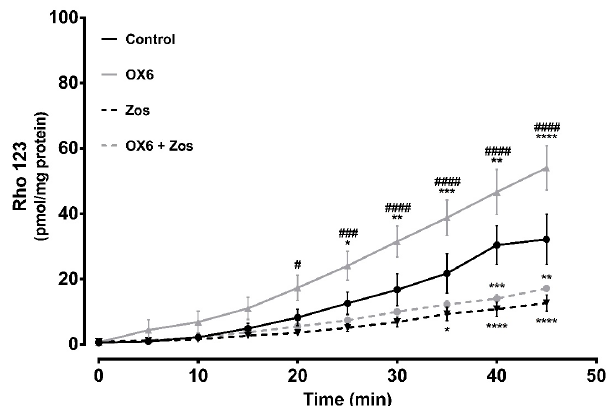
Figure 8. Short-term and direct effect of xanthone OX6 on P-glycoprotein (P-gp) activity, evaluated ex vivo. P-gp-mediated Rhodamine 123 (Rho 123) efflux was measured using 10 cm everted sacs from distal ileum. The sacs were filled with 300.0 μ M Rho 123 (serosal side). The dye secreted into the outside compartment (mucosal side) was assessed every 5 min for 45 min, in the presence or absence of 20.0 μ M OX6 and/or 10.0 μ M zosuquidar (Zos). Data are expressed as means ± SEM of five to eight rats per group. The excreted amounts of Rho 123 into the mucosal side were evaluated by spectrofluorometry, using a Rho 123 calibration curve, and expressed as pmol of Rho 123 transported per mg of tissue. Statistical comparisons were made using two-way ANOVA followed by the Tukey’s multiple comparisons post hoc test (* p <0.05; ** p <0.01; *** p < 0.001; **** p < 0.0001 vs.